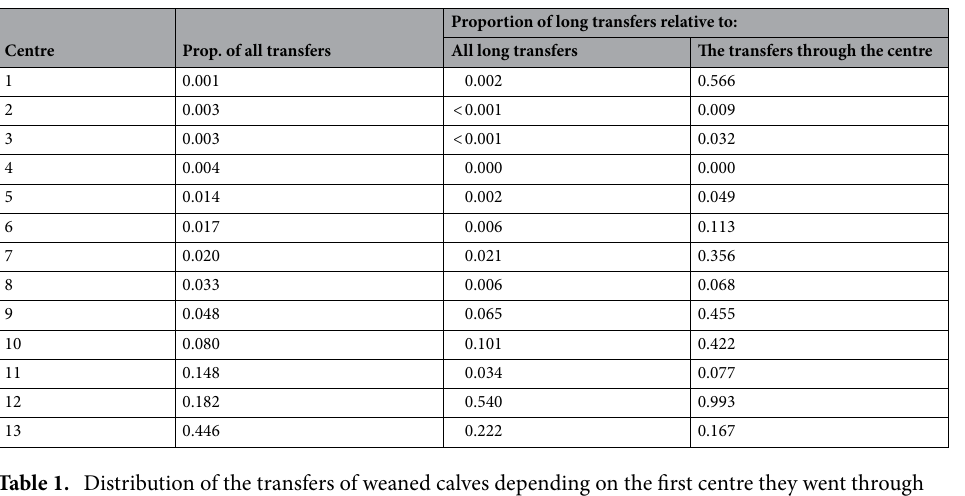
Table 1. Distribution of the transfers of weaned calves depending on the first centre they went through according to the database. First column: the sorting centre considered. Second column: the proportion of all the transfers that went through a given centre. Third column, the proportion of long transfers (33% longest) that went through a given centre. Fourth column, the proportion of transfers through a given centre that were long-distance transfers (in the 33%